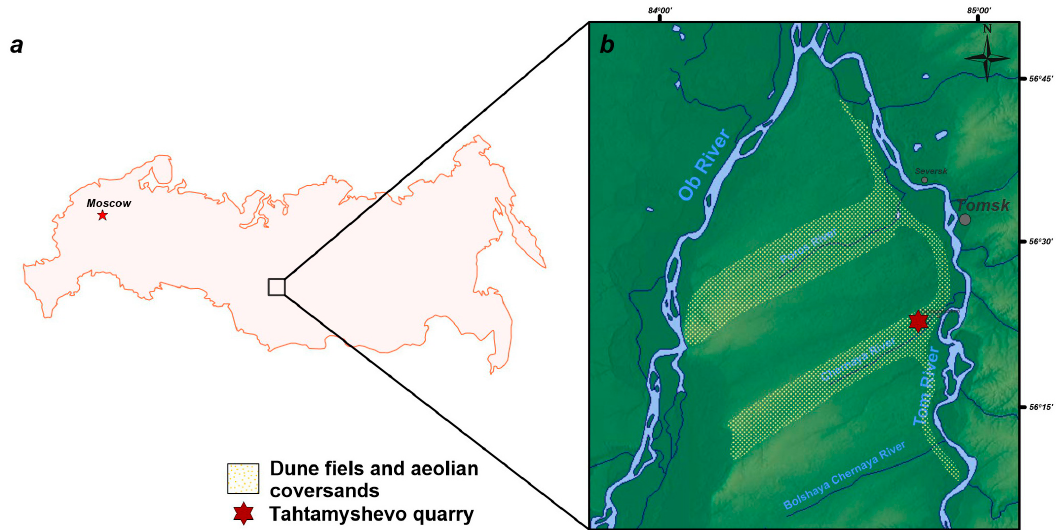
Figure 1. Location of the study area: ( a ) within the territory of Russia; ( b ) within the Ob–Tom interfluve.